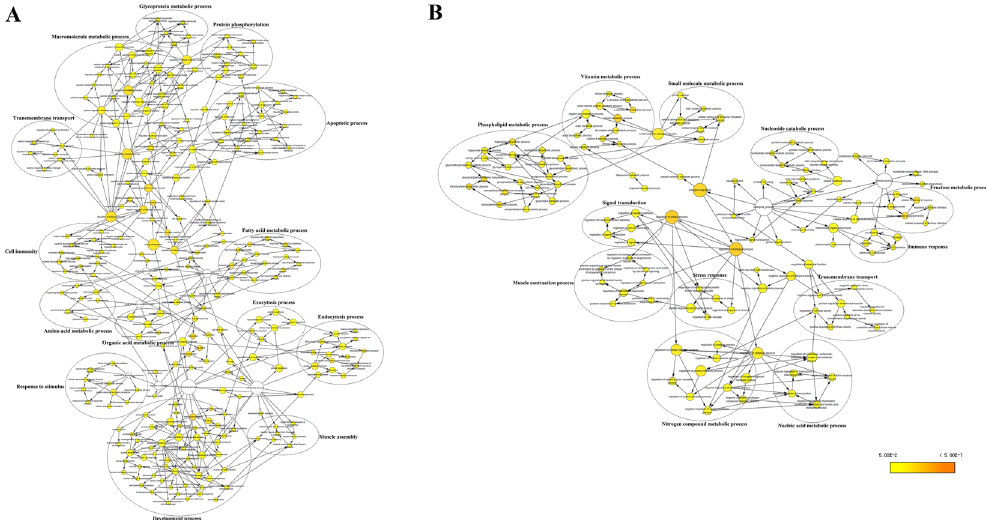
Figure 4. GO term overrepresentation analysis of biological processes. (A) Overrepresentation analysis of genes differentially expressed in the early samples. (B) Overrepresentation analysis of genes differentially expressed in the late samples. Nodes represent enriched GO terms. Edges connecting nodes indicate hierarchies and relationships between terms. Node size is proportional to the number of genes and proteins belonging to the functional category. Node color indicates the corrected P value for the enrichment of the term, according to the color legend. P < 0.05 was considered to be